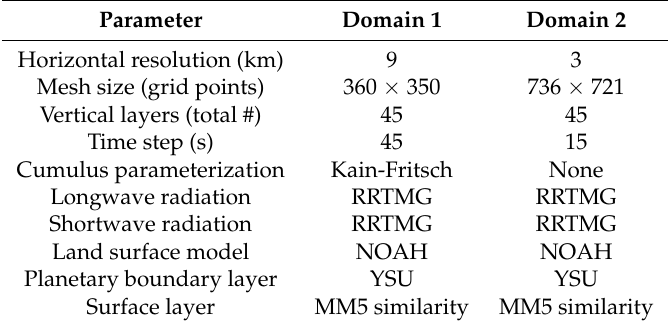
Table 1. The WRF-ARW mesoscale model